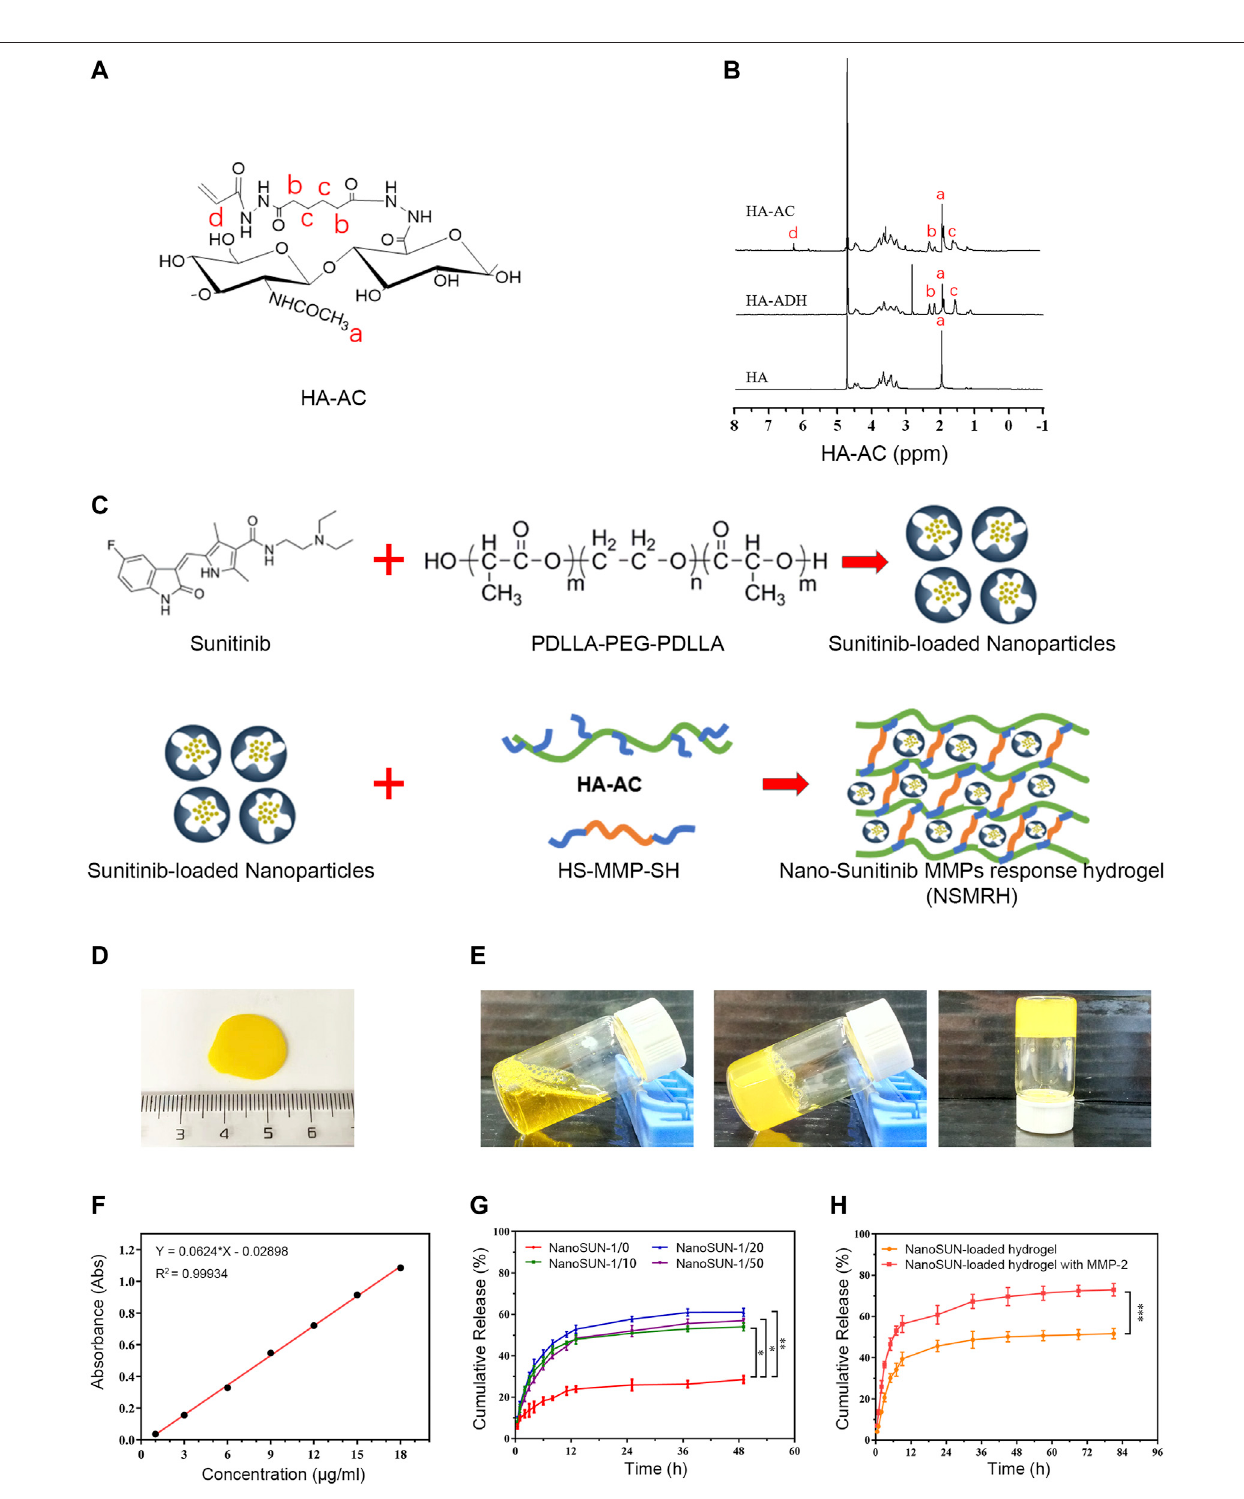
FIGURE2| MorphologyandcharacterizationofNSMRH. (A) ChemicalstructureofHA-AC. (B) HNMRofHA-AC. (C) processSchematicalprocessofNSMRH. (D) General morphological map of NSMRH. (E) Left: Photograph of the mixture solution at room temperature. Middle and right: Photograph of the as-prepared hydrogels formed in 5 min at 37 ° C. (F) Dissolution standard curve of nano-su. (G) and (H) Nano-su release pro fi le of NSMRH at various conditions.